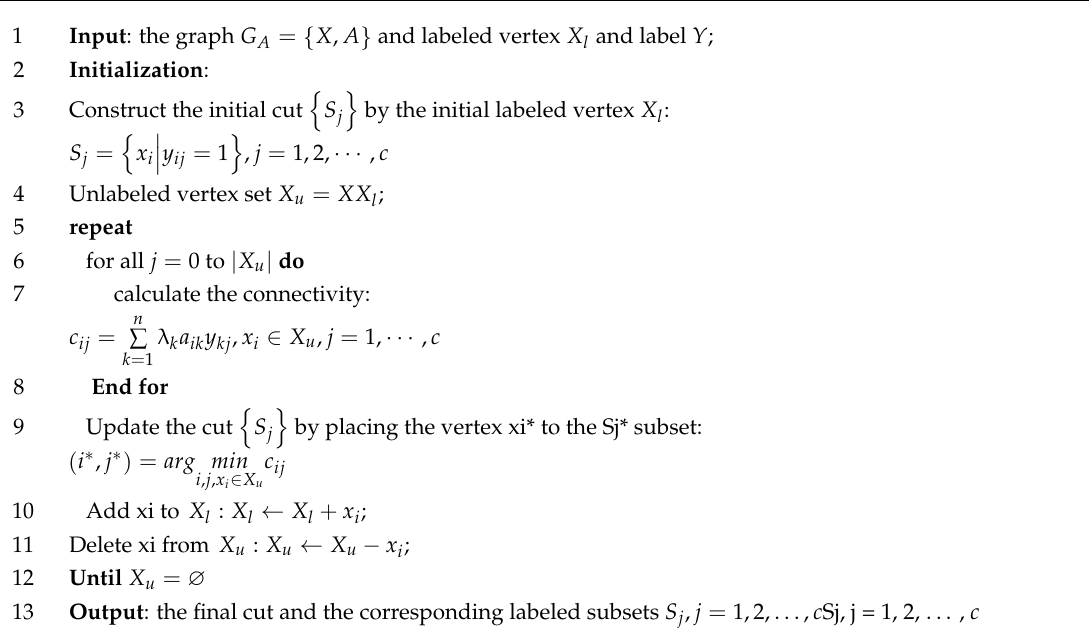
Algorithm 1. Greedy Gradient